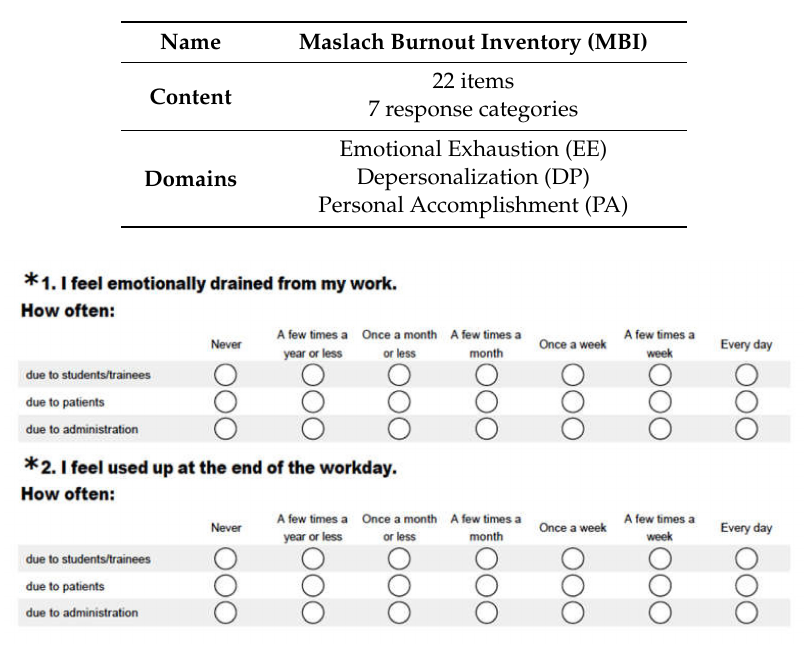
Figure 1. A section of the modified MBI scale (with